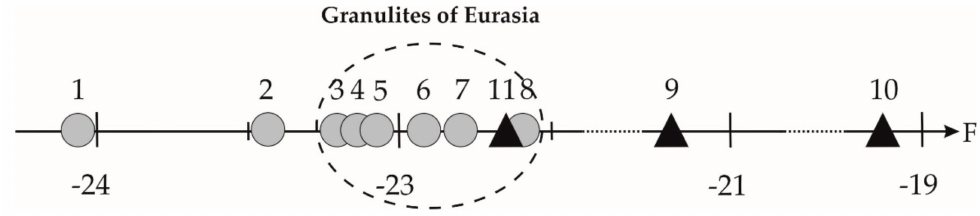
Figure 3. Location of points indicating compositions of rocks in the Kola region and granulite belts in Eurasia on the axis described by linear function F = − 0.39 × SiO 2 − 0.37 × TiO 2 − 0.38 × Al 2 O 3 + 0.12 × Σ Fe + 0.05 × MgO − 0.13 × CaO + 0.44 × Na + 0.57 × K 2 O 2 O. 1–7, ultrabasic-basic granulites of: (1) northeasternBalticShield(Lapland–Kolvitsagranulitebelt); (2)Baikalregion, Olkhon, andSharyzhalgay series; (3) Northeast Asia; (4) Ukrainian Shield (Pobuzhye); (5) southern and southwestern part of the Aldan Shield; (6) South and Southeast India; (7) Anabar Shield; (8) North China (1–8 correspond to the same in Figure 2). (9)–(11) ultrabasic-basic magmatic rocks of the Paleoproterozoic (9) and Paleozoic (10) Kola region, and an average composition of ultrabasic-basic rocks that formed Neoarchean proto-island arc belts, and later structures of the Kola region up to the Paleozoic ( 11